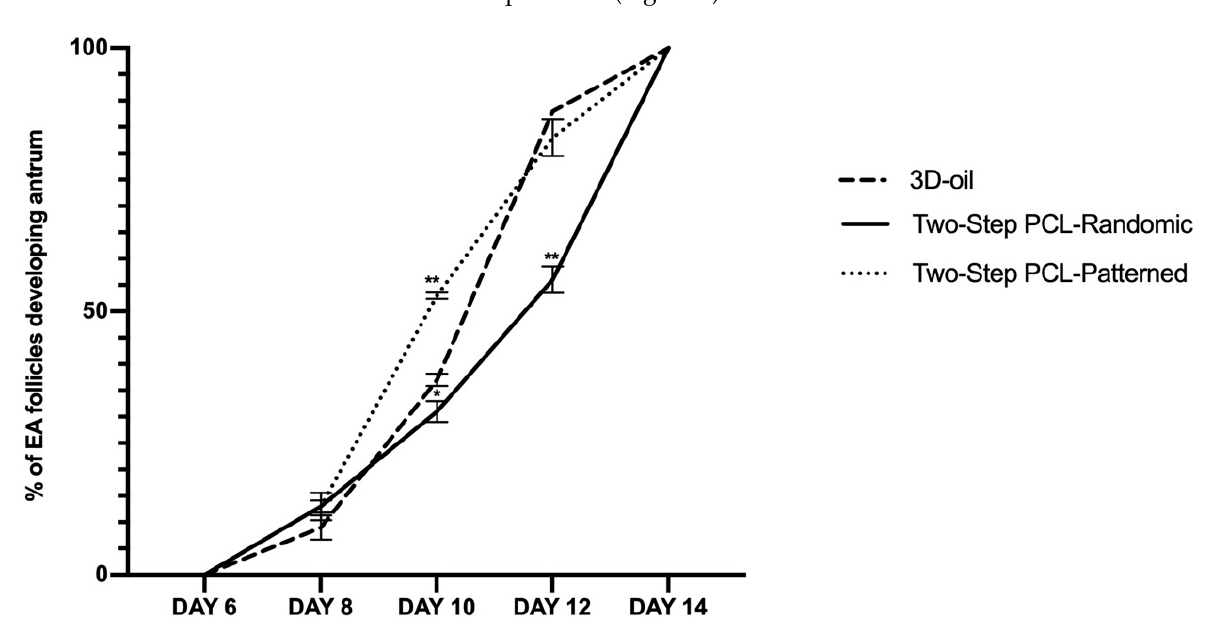
groups. A total of 120, 125, and 122 follicles were cultured in three independent experiments during